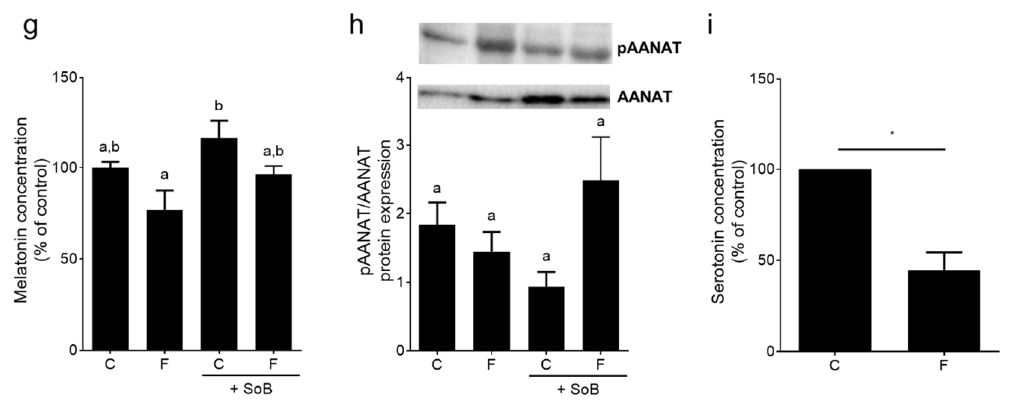
Figure 7. E ff ect of SoB on melatonin and serotonin concentration, protein expression of AANAT and activity of histone deacetylases enzymes in everted small intestinal sacs. ( a ) Melatonin concentration in whole intestinal tissue specimen, ( b ) activity of HDAC enzymes, and ( c ) representative blot of acetylated histone complex H3 protein expression treated with SoB. ( d ) Phosphorylated AANAT in mucosa of intestinal tissue obtained of everted sacs of naïve mice challenged with 6 mM SoB, ( e , g ) melatonin concentration and ( f , h ) phosphorylated AANAT in whole intestinal tissue obtained of everted sacs treated with 6 mM NADPH and / or 6 mM SoB as well as 10 mM fructose and / or 6 mM SoB. ( i ) Serotonin concentration in whole intestinal tissue specimen treated with 10 mM fructose. Data are expressed as means ± SEM, n = 3–6. * p < 0.05. Data with di ff erent letters are significantly di ff erent, p < 0.05. Aanat, serotonin N-acetyltransferase; Ac-H3 (Lys9), acetylated histone complex H3; C, everted gut sacs incubated only in 1 × Krebs–Henseleit-bicarbonate-bu ff er; F, fructose; HDAC, histone deacetylases; NADPH, nicotinamide adenine dinucleotide phosphate (reduced form); SoB, sodium